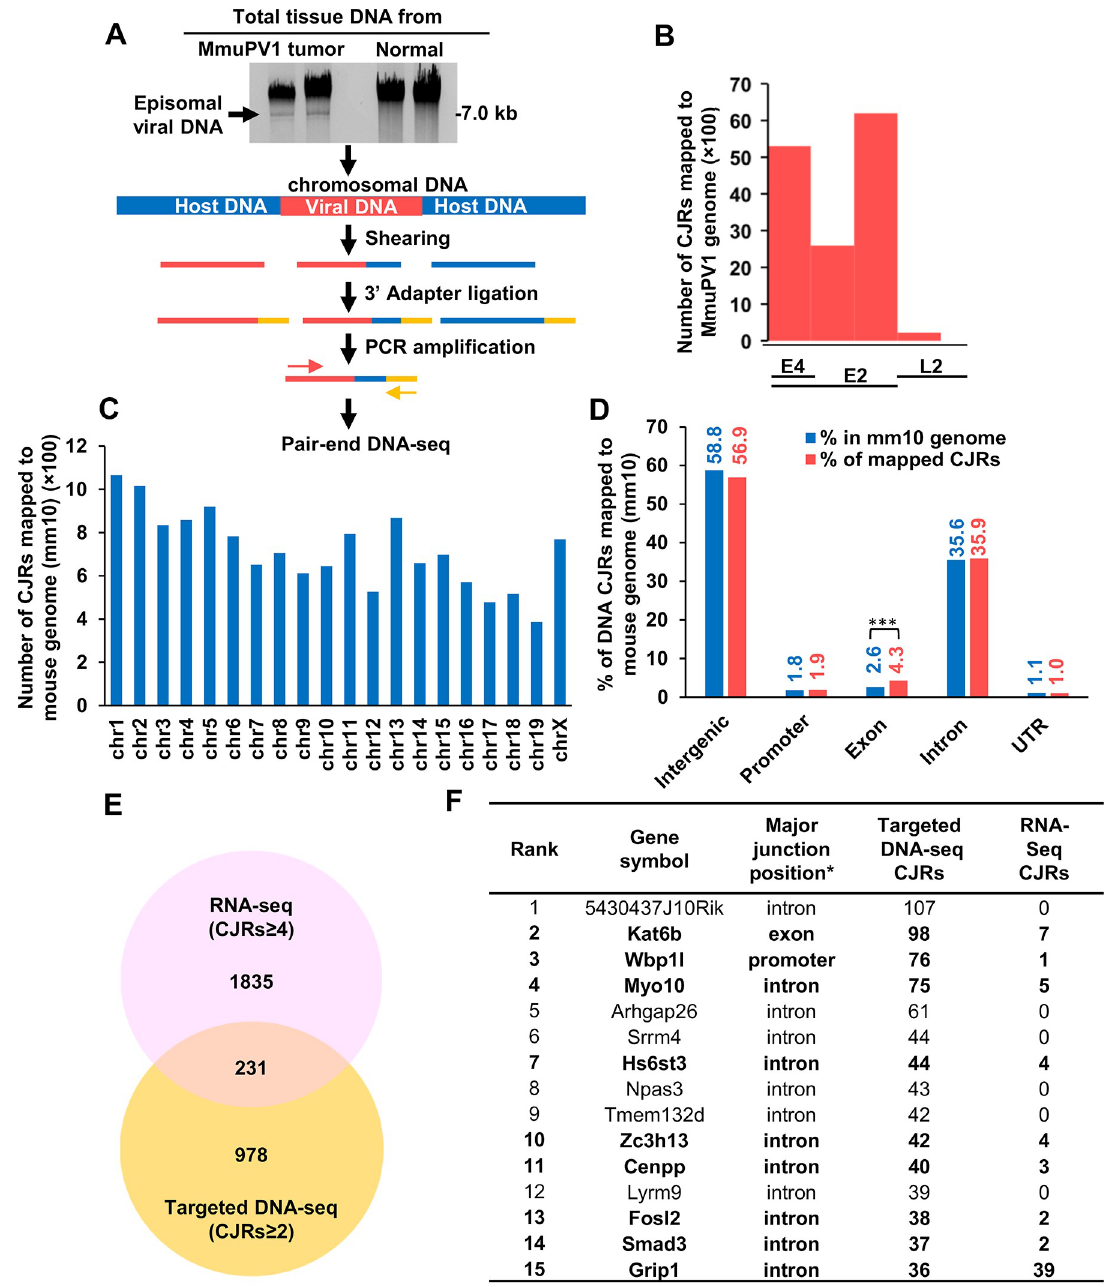
Fig 4. Detection of MmuPV1 integration sites in MmuPV1 tumor tissues by targeted DNA-seq. A, Schematic presentation of the strategies for detecting the integration sites for MmuPV1 DNA in chromosomal DNA by targeted DNA-seq. Tumor or normal ear tissues of animal #2 ( Fig 2B ) were dissected and used for genomic DNA extraction. The episomal viral genomes were separated from the chromosomal DNA by agarose gel electrophoresis and the genomic DNA was isolated from the gel and sheared by sonication. The sheared DNA fragments were end-repaired and their 3’ ends were ligated to an adaptor. Three specific viral primers (Pr2976, Pr3277 and Pr3742) at MmuPV1 E2 region ( S10 Table ) were used separately, in combination with an adapter primer, to selectively PCR amplify chimeric virus-host DNA fragments, and the amplicons were then sequenced. B, Distribution of integration breakpoints in the MmuPV1 genome by mapped CJRs from targeted DNA-seq. C, Chromosomal distribution of the MmuPV1 integration sites in the mouse genome by mapped CJRs. D, The proportion of different host genomic regions with MmuPV1 integration sites. ��� , P < 0.001 in Chi-squared test. E, Genes with MmuPV1 integration sites that were identified by RNA-seq (CJRs � 4) and verified by targeted DNA-seq (CJRs � 2) are shown in a Venn diagram. F, The top 15 genes with the most MmuPV1 integration sites identified by targeted DNA-seq and RNA CJRs detected by RNA-seq.